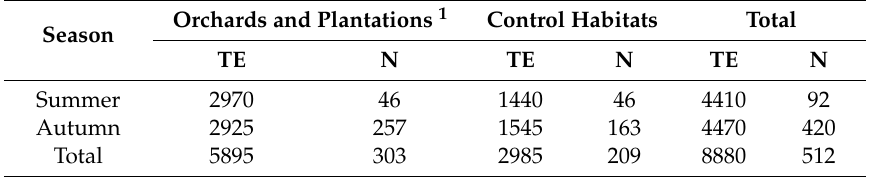
Table 2. Summary of trapping results in 2018 in the commercial fruit farms and control habitats. Orchards and Plantations 1 Control Habitats Total Season TE N TE N TE N Summer 2970 46 1440 46 4410 92 Autumn 2925